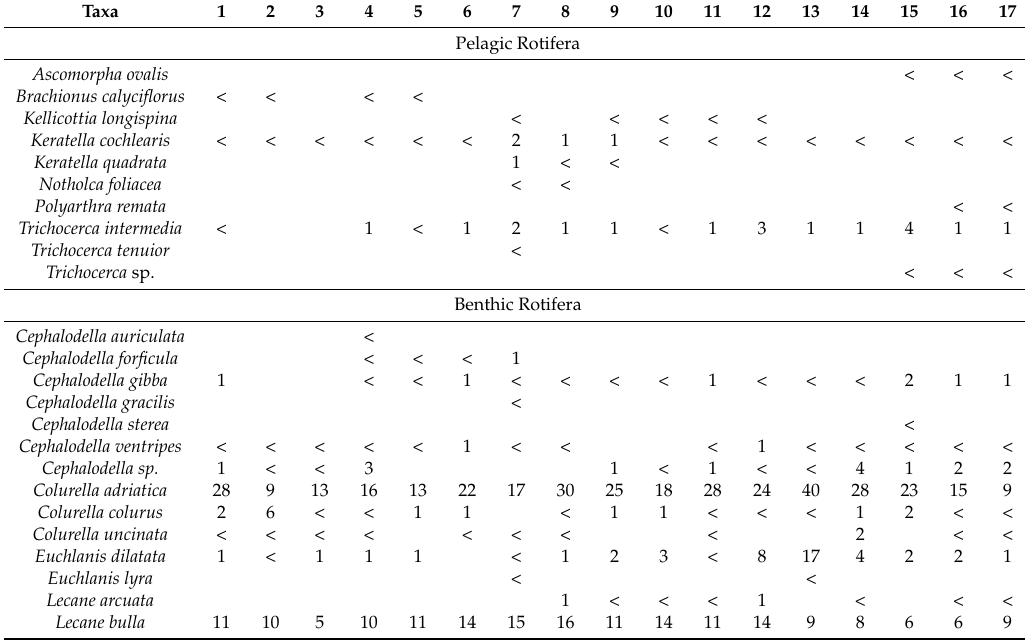
Table 3. Taxonomic composition and percentage contribution of zooplankton taxa in mean abundance of total zooplankton at examined